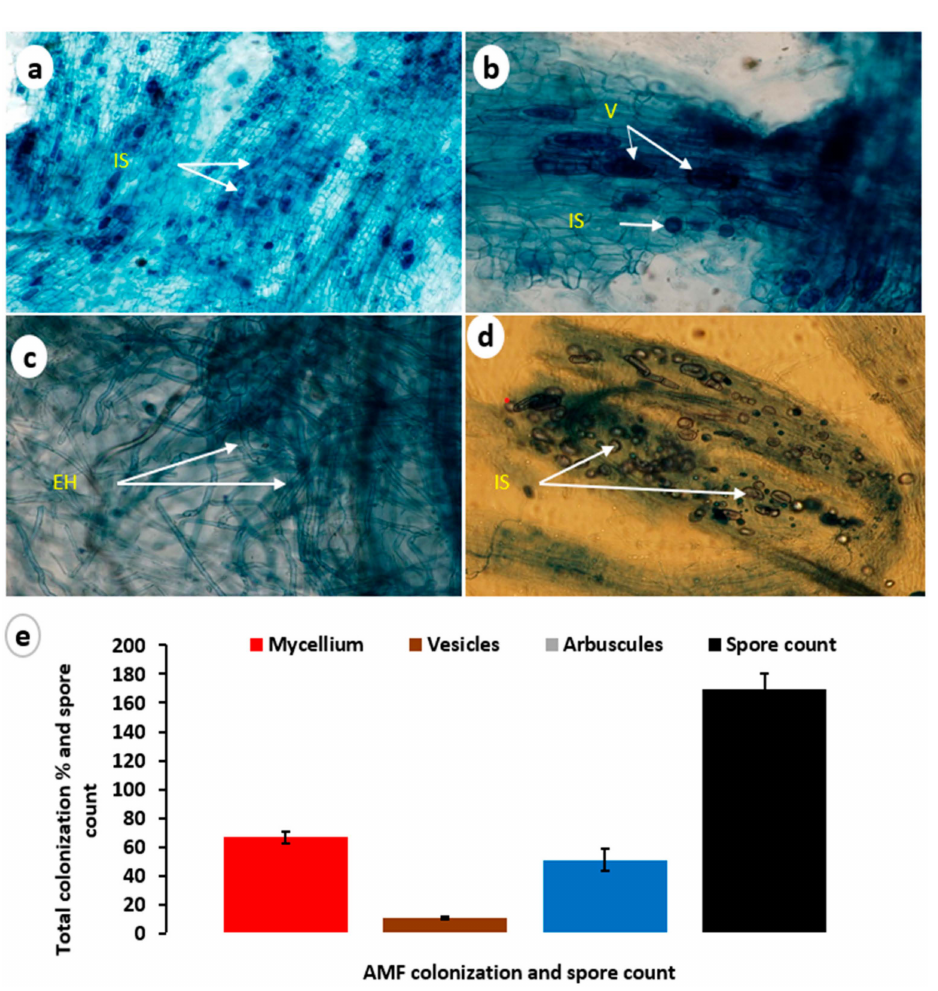
Figure 2. Photomicrographs indicating the root colonization structures and colonization status in the roots of Philodendron bipinnatifidum in response to arbuscular mycorrhizal fungi after 8 weeks acclimatization. (( a – d ) 400 × magnification). The presence of extraradical hyphea (EH) indicated initiation of AMF colonization, which later propagated and developed various structural forms such as intraradical intact spores (IS); Vesicles (V). ( e ) AMF root colonization (Mycelium, Vesicles, and Arbuscules) and spore count of Philodendron